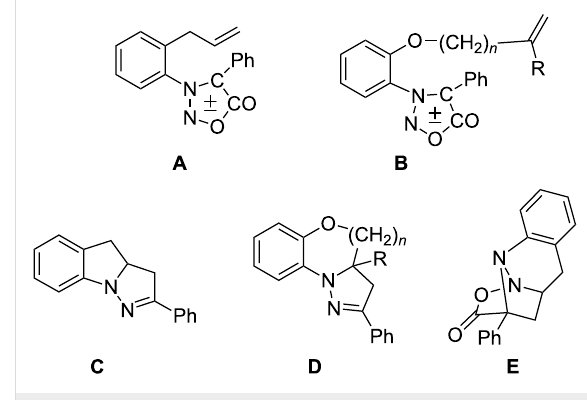
Figure 1: Resonance structures of the sydnone ring.